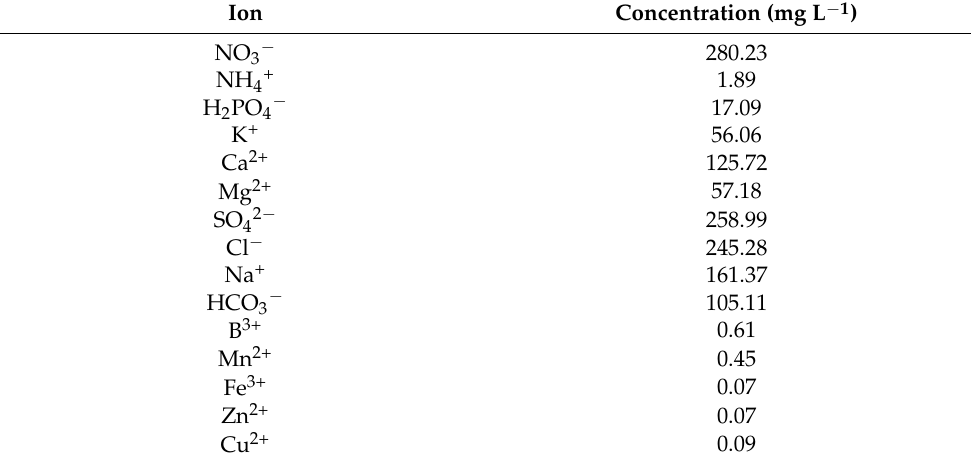
Table 1. Composition of major ions in the irrigation solution used in the